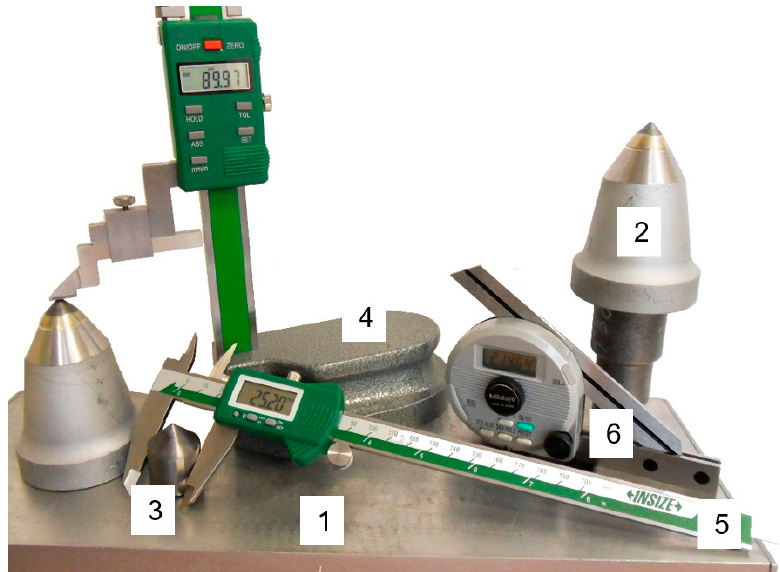
Figure 6. Instruments for measuring linear and angular dimensions: (1) surface plate; (2) conical pick; (3) WC-Co insert; (4) altimeter; (5) calliper; and (6) protractor [28,29].